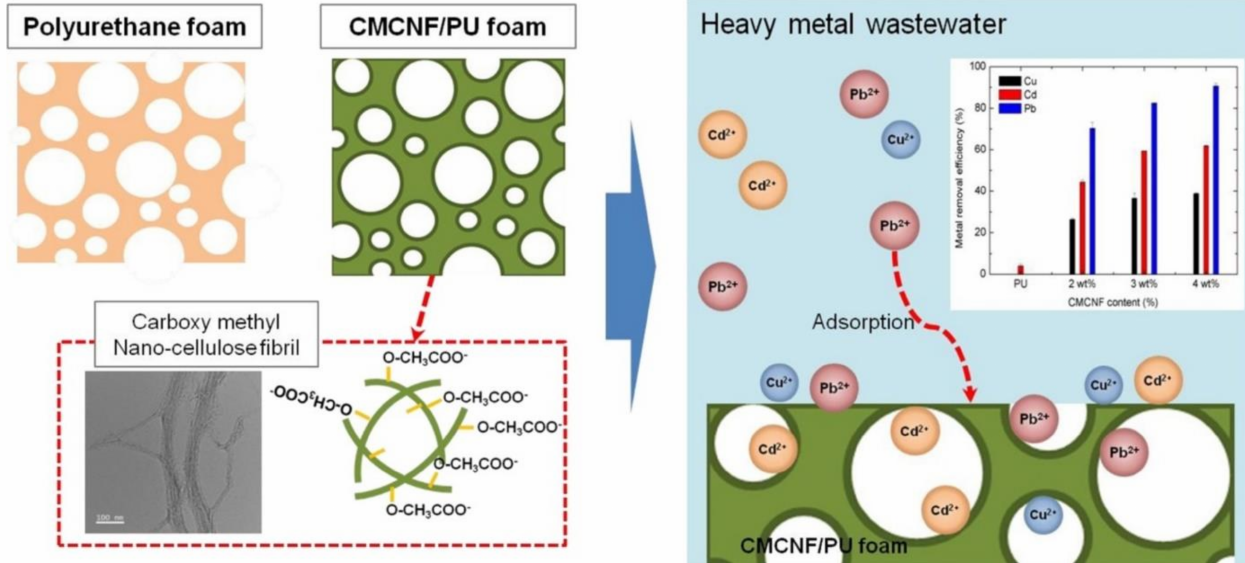
Figure 3. Fabrication of a template structure for carboxymethylated (CM) cellulose nanofibers (CNF) with polyurethane (PU) foam with controlled pore structure, for use as a modular adsorbent of heavy metals (Cd 2+ , Cu 2+ , Pd 2+ ) in contaminated water [94], ©Elsevier,